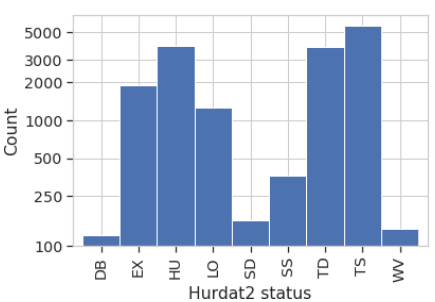
Figure A1. Distribution of the cyclone categories/status computed over the period